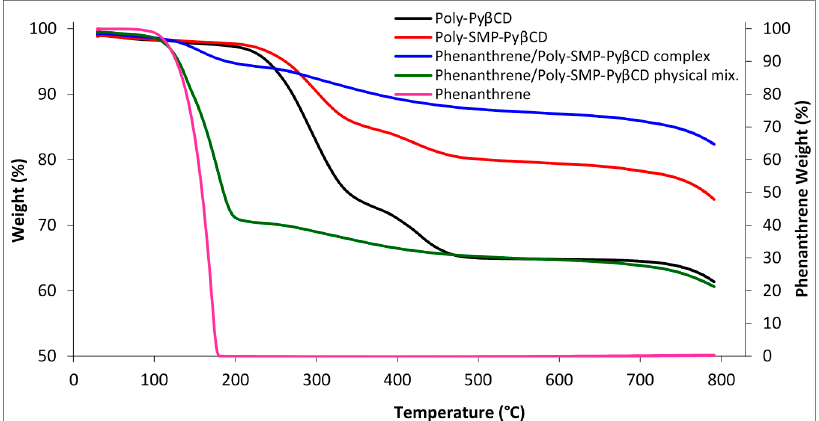
Figure 5. TGA analysis of the Poly-Py β CD, Poly-SMP-Py β CD, phenanthrere/Poly-SMP-Py β CD complex, phenanthrene/Poly-SMP-Py β CD physical mixture and pure phenanthrene. Weight loss of phenanthrene is shown on the right side of the graph while others on the left side of graph.